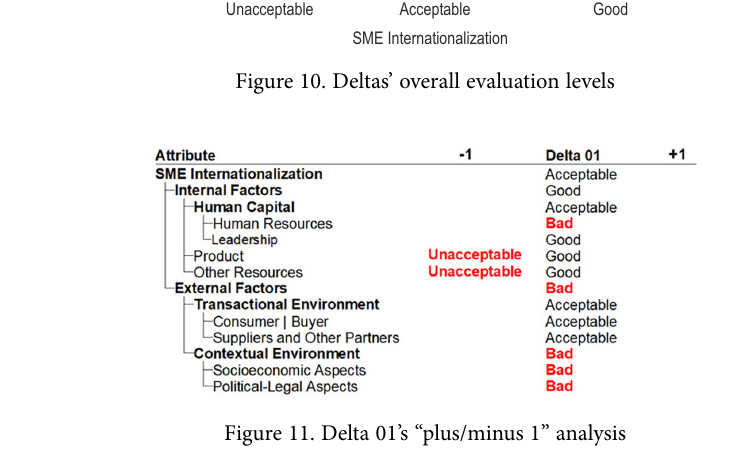
Figure 11. Delta 01’s “plus/minus 1” analysis